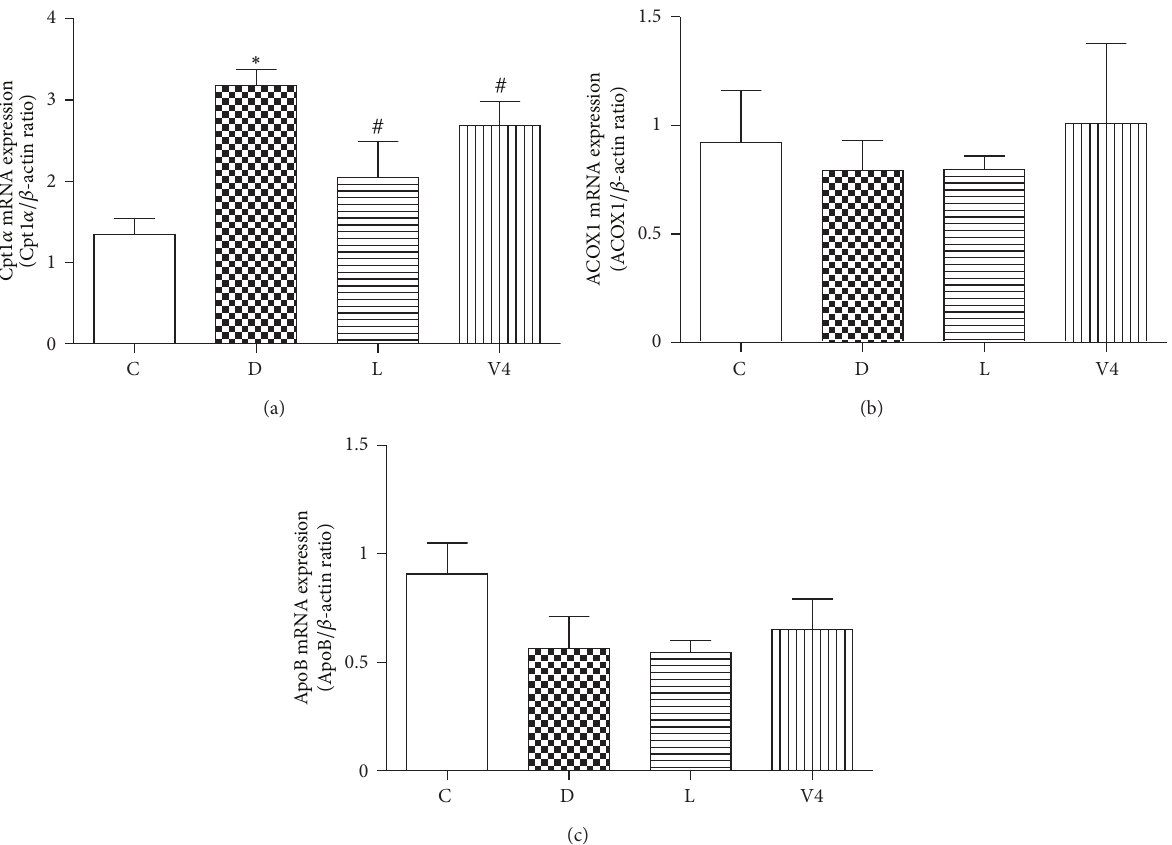
Figure 6: Effects of V 4 dipic-Cl on mRNA expression levels of Cpt1 𝛼 , ACOX1 and ApoB in STZ-induced diabetic rats. C: Control group, D: Diabetic group, L: H 2 dipic-Cl-treated group, V4: V 4 dipic-Cl-treated group. Values are expressed as mean ± SEM, 𝑛 = 3 . ∗ 𝑃 < 0.05 versus C. # 𝑃 < 0.05 versus